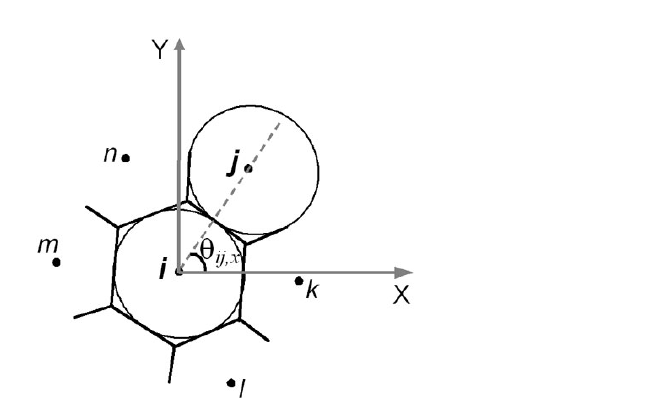
Figure 5: An example of definition of angle  between line connecting mass centers of discrete elements in the pair i-j and  -axis of ij,  laboratory system of coordinates (  = X is considered here). The center of coordinate system is translated to the mass center of the element